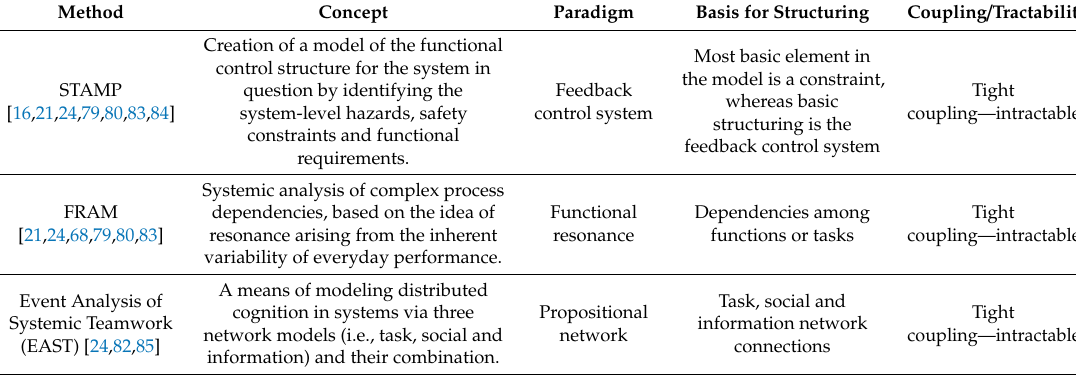
Table 2. Complexity-thinking-inspired safety analysis methods (concept, paradigm and basis for structuring).